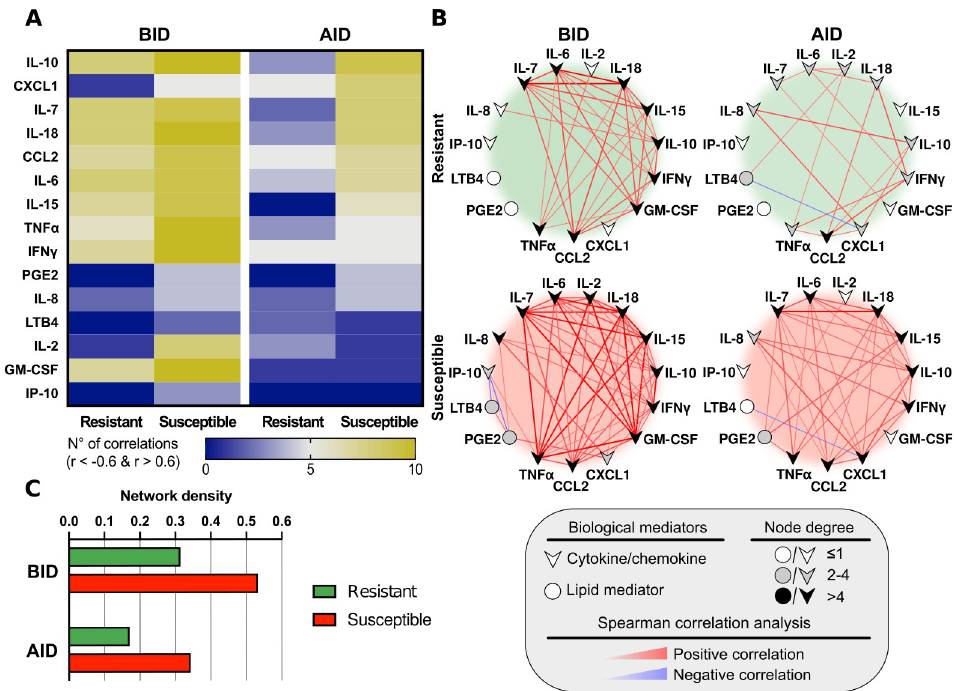
Fig 5. Network analysis of biological mediators in canine sera. ( A ) Heatmap depicting strong statistically significant correlations (Spearman’s test, r � 0.6 or r � -0.6, p < 0.05) between the biological mediators measured in CVL-resistant and susceptible canine serum, at 6–12 months prior to detection of Leishmania infantum (BID: Before Infection Diagnosis), and 6–12 months after the time of diagnosis (AID: After Infection Diagnosis). ( B ) Network analysis (host interactome) showing interactions between the strong statistically significant correlations (Spearman’s test, r � 0.6, p < 0.05) between the biological mediators measured in CVL-resistant and susceptible dogs before (BID) and after (AID) infection diagnosis. Positive correlations are shown in red, while blue denotes negative correlations. ( C ) Comparison of Network densities (nodes analysis) of CVL-resistant and susceptible dogs, before and after infection diagnosis.